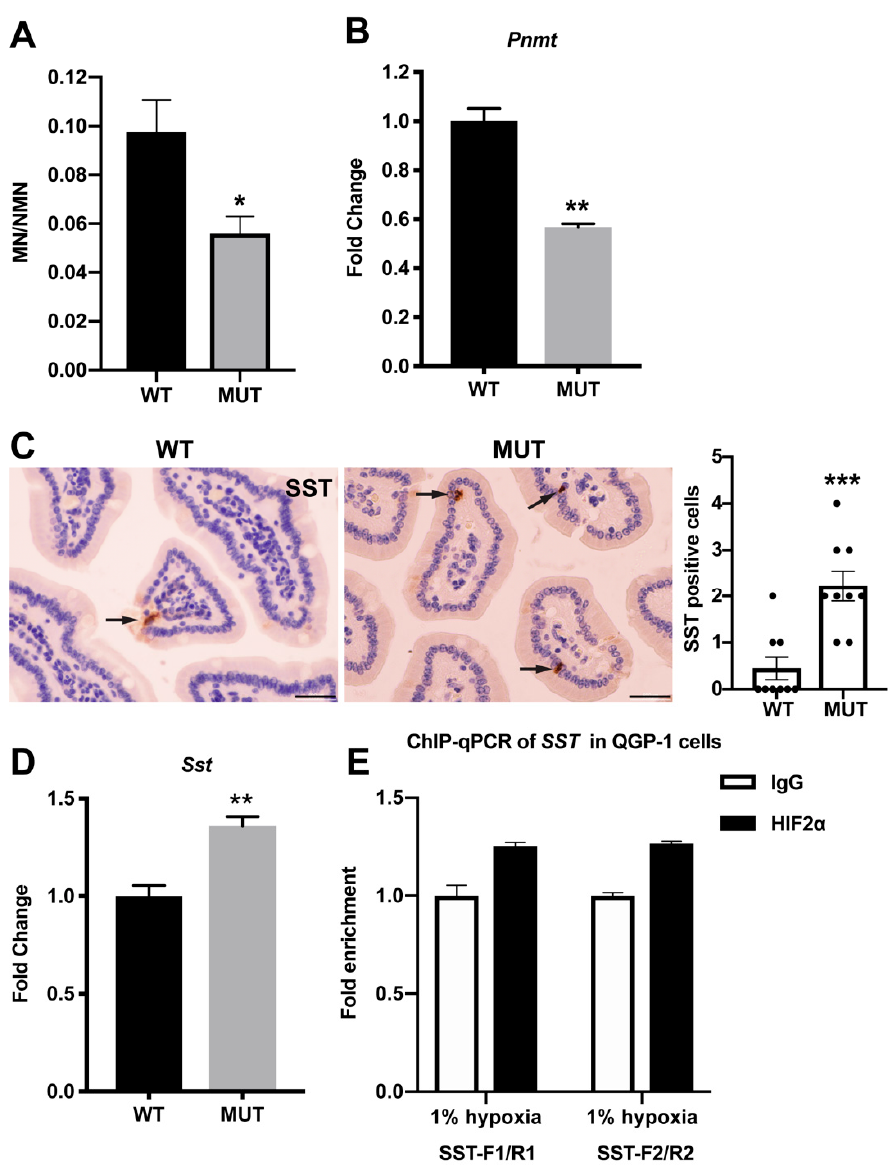
Figure 4. Epas1 A529V mutant mice recaptured the biochemistry characteristics of the syndrome. ( A ) Decreased metanephrine (MN) / normetanephrine (NMN) ratio in three–five-month-old mutant mice. n (WT) = 6, n (MUT) = 7. * p < 0.05. ( B ) Decreased Pnmt mRNA in mutant adrenal gland. ** p < 0.01. ( C ) SST IHC staining of duodenum of control and mutant mice. Arrows indicate SST-positive cells. SST-positive cells were counted in nine random fields of view (400 × ) and summarized in the right column. *** p = 0.0005. Scale bars, 30 µ m. ( D ) Increased Sst mRNA in mutant duodenum; n = 3